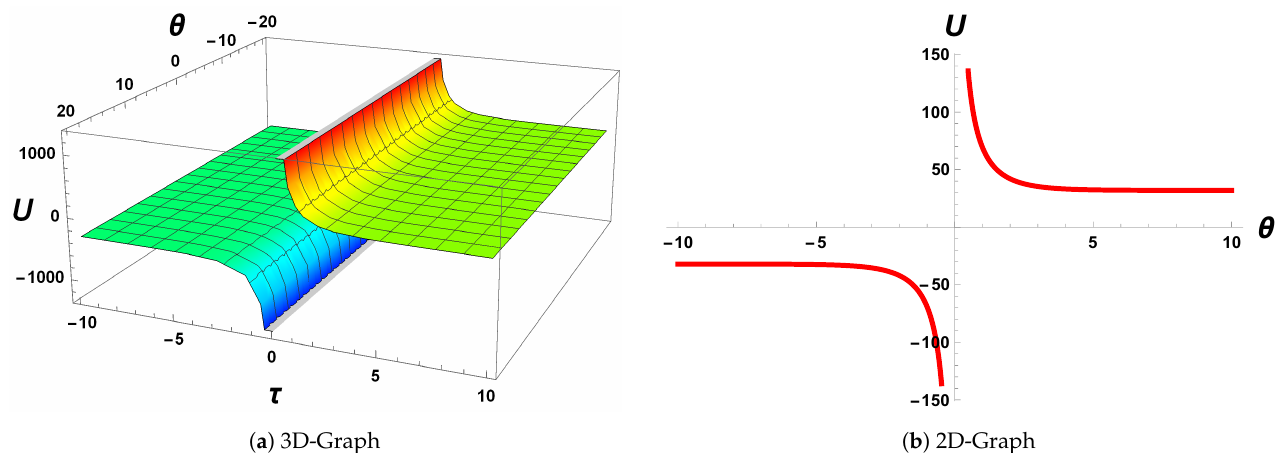
Figure 7. Diagrams a − 3 D and b − 2 D representation of U 8 ( θ , τ ) for l 1 = 0.2, l 2 = 0.1, δ = 1.5, γ 1 = 0.5, γ 2 = 0.15, and γ 3 = 1.7.